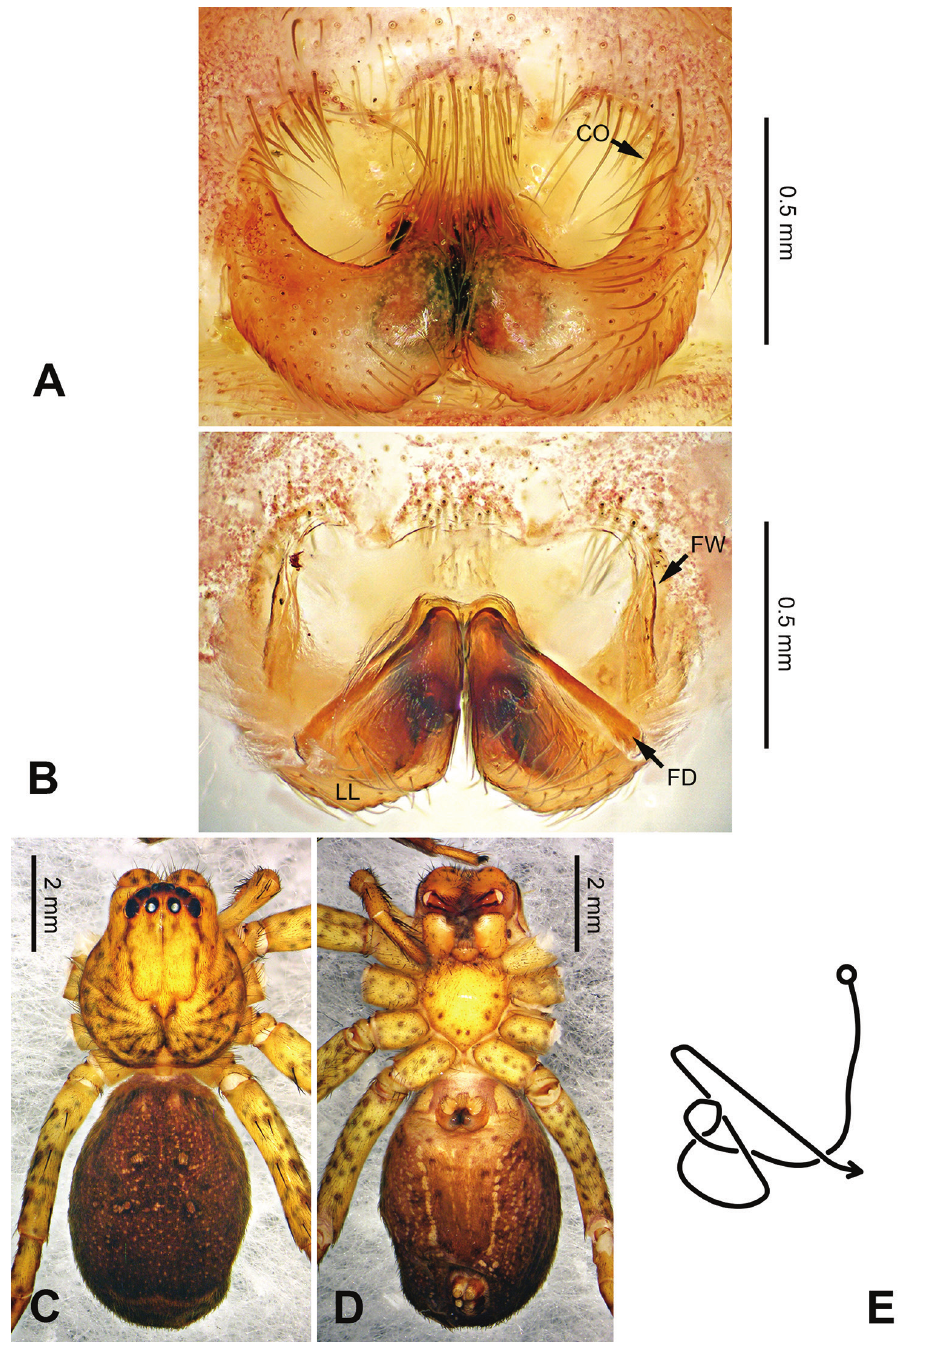
Figure 24. Pseudopoda shuo Zhao & Li, sp. n., paratype female. A Epigyne, ventral view B Vulva, dorsal view C Habitus, dorsal view D Habitus, ventral view E Schematic course of internal duct system, dorsal